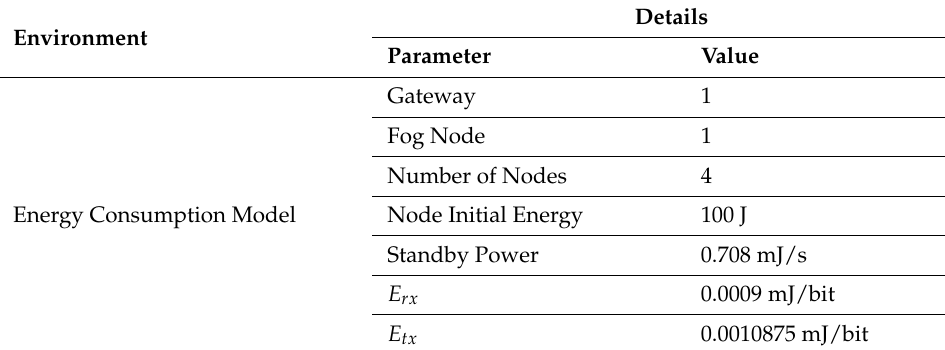
Figure 9. Residual energy of BMCTM and MCTM in blackhole and greyhole attack scenarios. Table 4. Experimentation